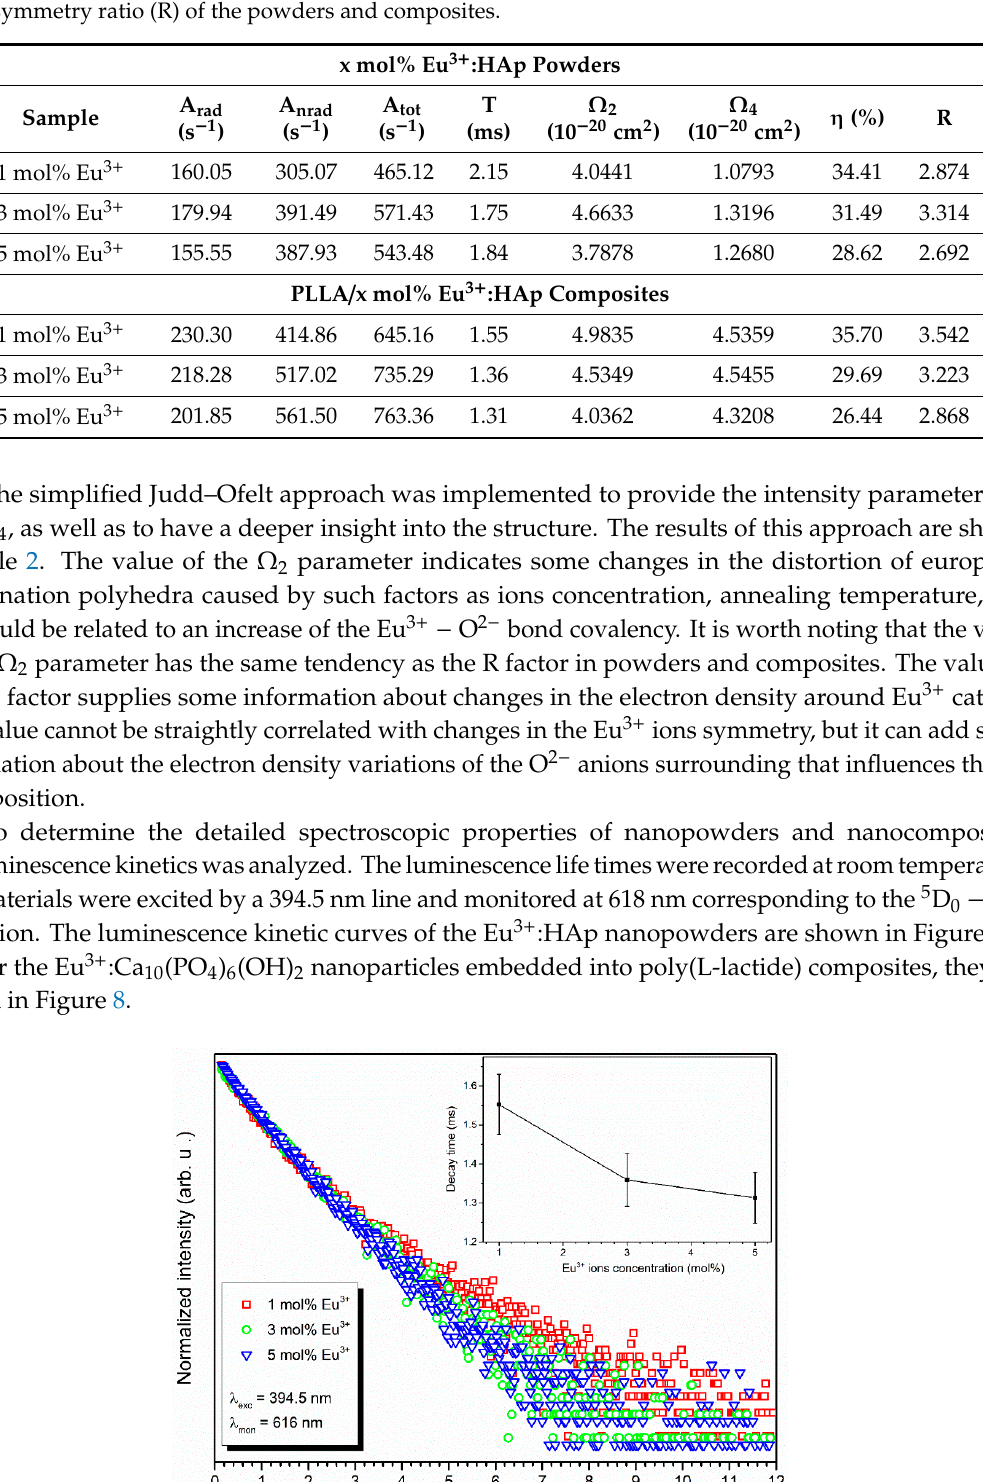
Table 2. Decay rates of radiative (A rad ), non-radiative (A nrad ) and total (A tot ) processes of 5 D 0 → 7 F J transitions, luminescence lifetimes ( τ ), intensity parameters ( Ω 2 , Ω 4 ), quantum e ffi ciency ( η ) and asymmetry ratio (R) of the powders and composites.